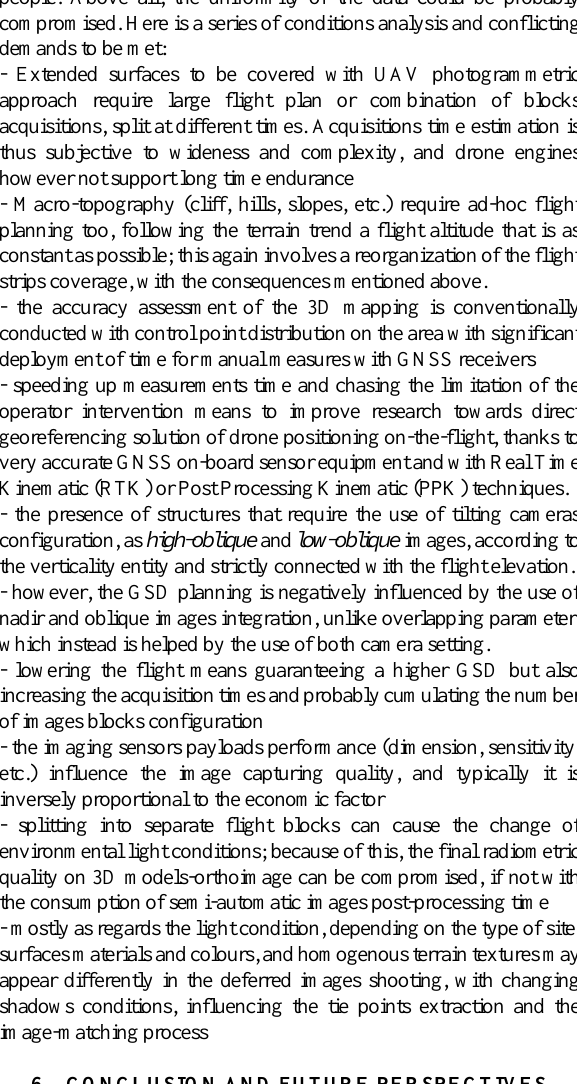
Figure 8. The comparison between the two point clouds: (a) nadir+oblique integration; (b) nadir-only view; (c) C2C comparison map representing the difference and the contribution on oblique